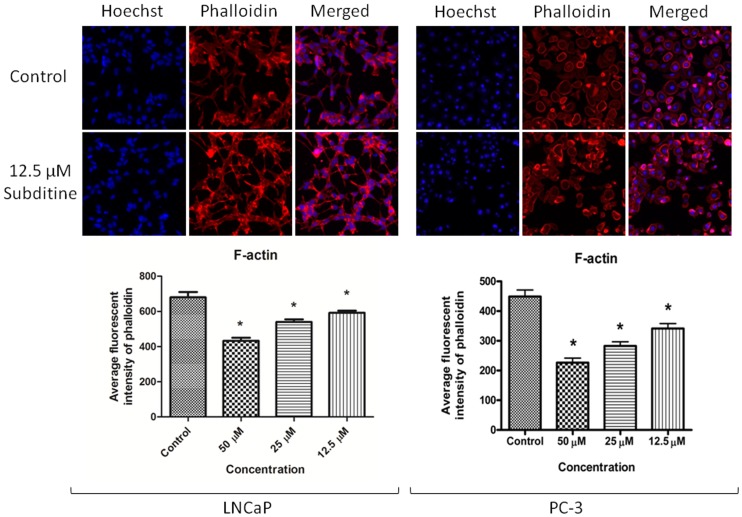
Subditine (1) induced cytoskeletal rearrangement at the peripheral.LNCaP and PC-3 cells were treated with subditine (1) at various concentrations for 24 hours. Cells were fixed and stained with Hoechst (blue) and phalloidin (red) dye which stained nucleus and polymerized actin (F-actin), respectively. Bar chart showing average fluorescent intensity of phalloidin (mean ± S.D.; *p<0.05). Dose-dependent increased of phalloidin intensity in LNCaP cells were observed after subditine treatment.